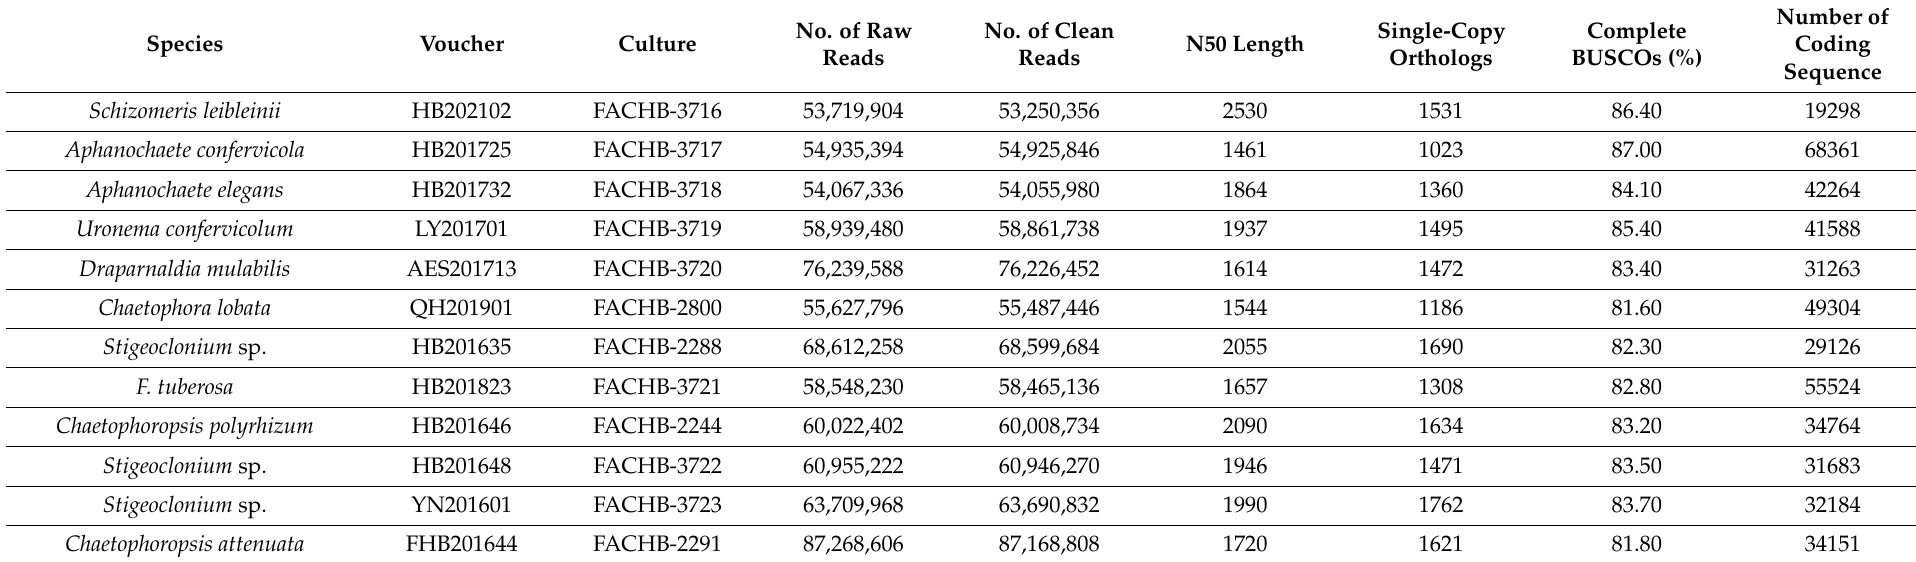
Table 1. Summary of transcriptome data of the